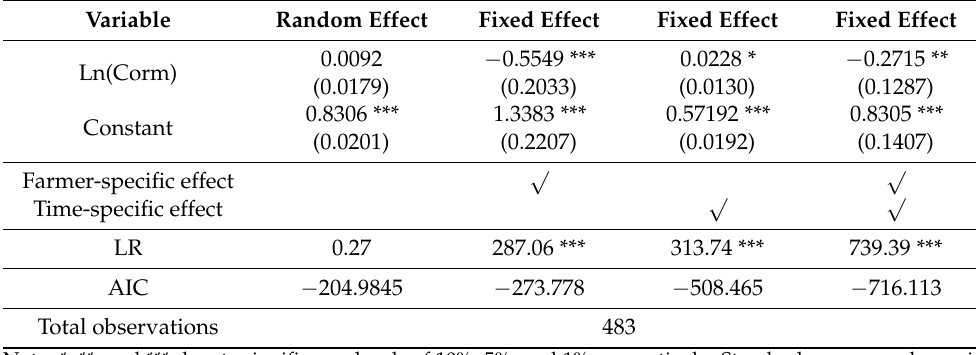
Table 7. Panel OLS estimation results of the effect of corm planting density on technical efficiency.